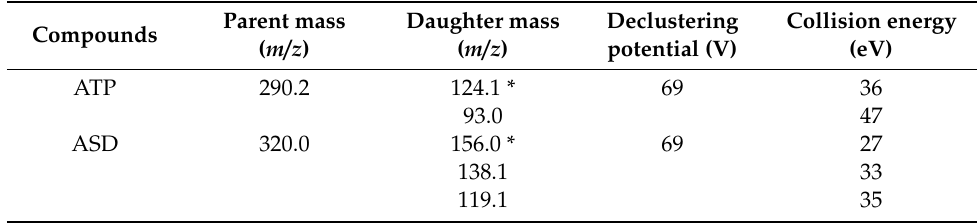
Table 1. Tandem mass spectrometry (MS / MS) parameters for determination of atropine sulfate (ATP) and anisodine (ASD). Parent mass Daughter mass Compounds ( m / z ) ( m / z )